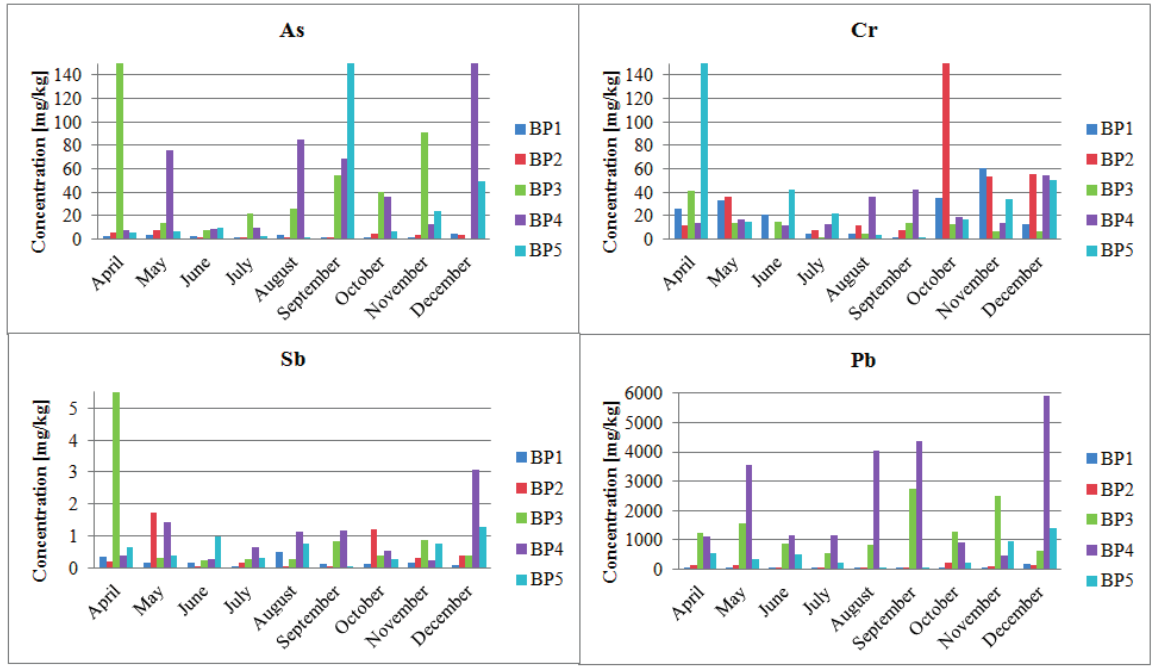
Figure 5. Total contents of arsenic, antimony, chromium and lead in the Bia ł a Przemsza River bottom sediments; sampling points: BP1—Chrz ą stowice; BP2—Klucze Osada; BP3—D ą browa Górnicza Okradzionów; BP4—S ł awków; BP5—Sosnowiec. Table 5. The sieve analysis of the Bia ł a Przemsza River bottom sediments; sampling points: BP1—Chrz ą stowice; BP2—Klucze Osada; BP3—D ą browa Górnicza Okradzionów; BP4—S ł awków; BP5—Sosnowiec. BP1 April